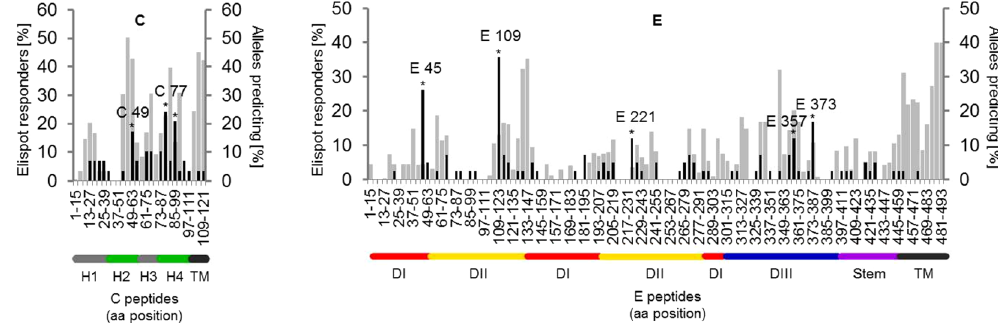
Figure 4. Comparison between experimentally identified CD4 T cell epitopes and in silico epitope predictions based on peptide-MHC II affinity. Percentages of HLA class II alleles predicting a specific 15-mer peptide for C (left panel) and E (right panel). The experimentally defined immunodominant epitopes are denoted by the first amino acid of the 15mer peptide used for single peptide testing; in silico predicted epitopes (grey), experimentally determined epitopes